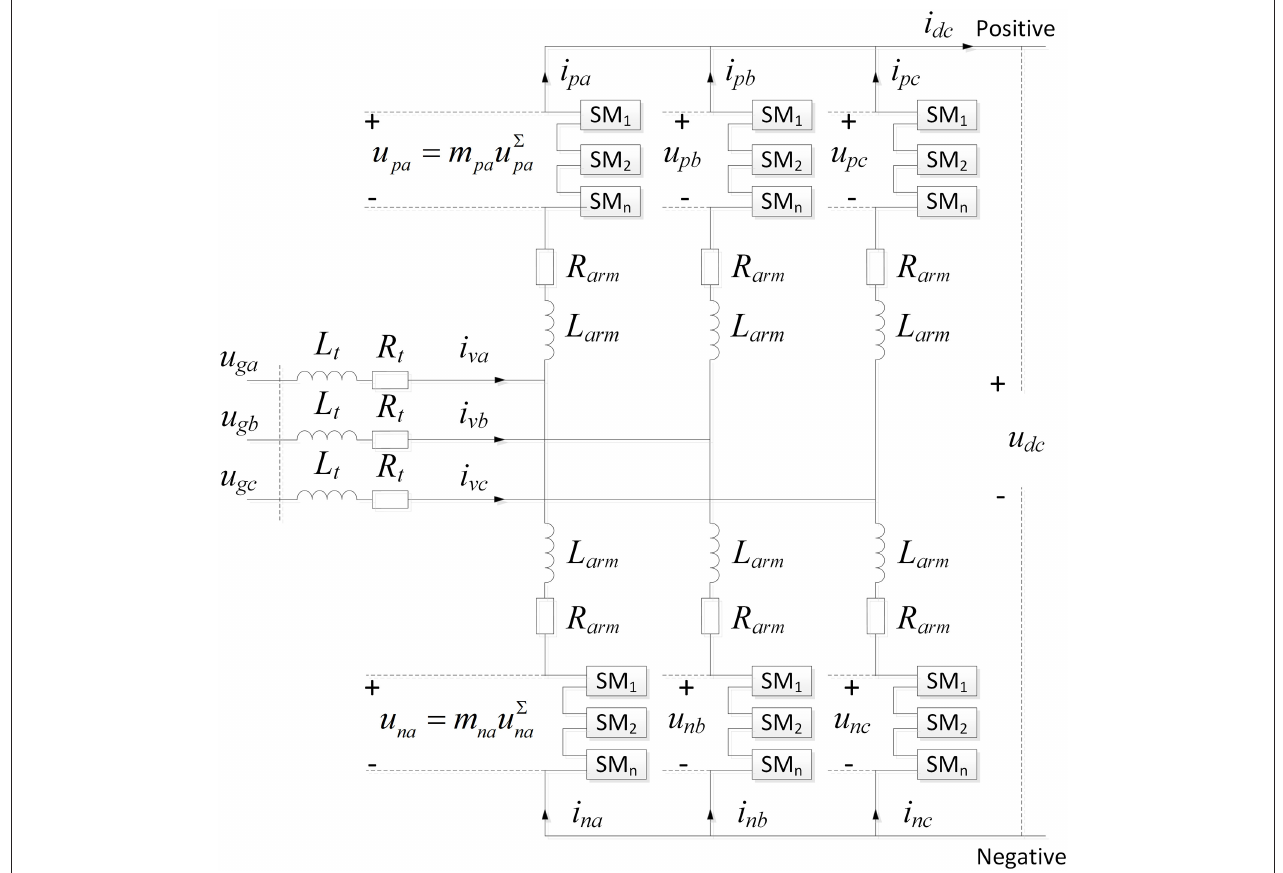
FIGURE 1 | Detailed topology of an MMC converter station positive